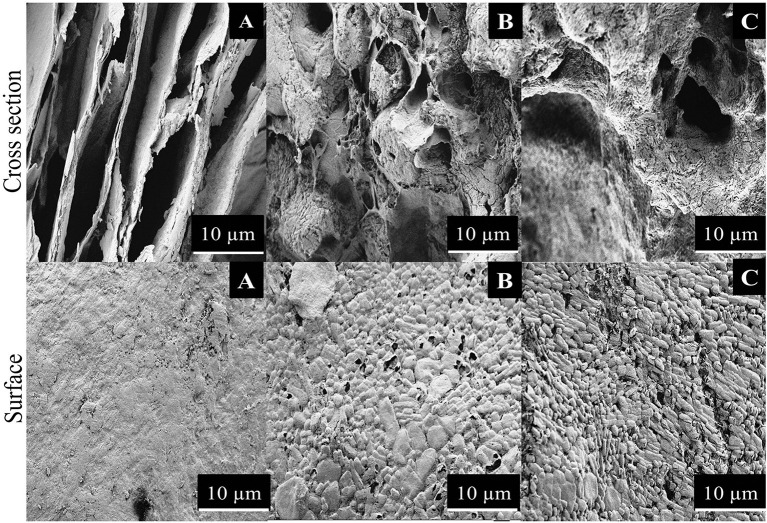
SEM images of (A) R-BC, (B) R-BC-famotidine, and (C) R-BC-tizanidine matrices.